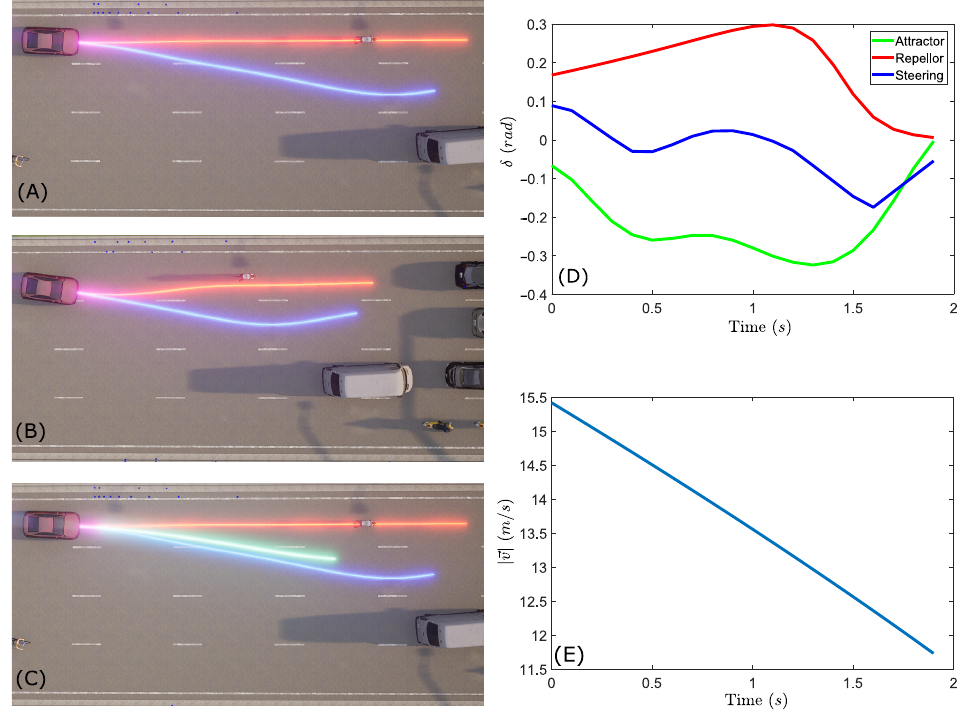
Figure 9. ( A ) First frame; ( B ) second frame; ( C ) third frame. ( D ) Resulting steering angle calculated by the influence of the attractor, repellers, and velocity constraints. ( E ) Velocity profile generated for blue trajectory in the first